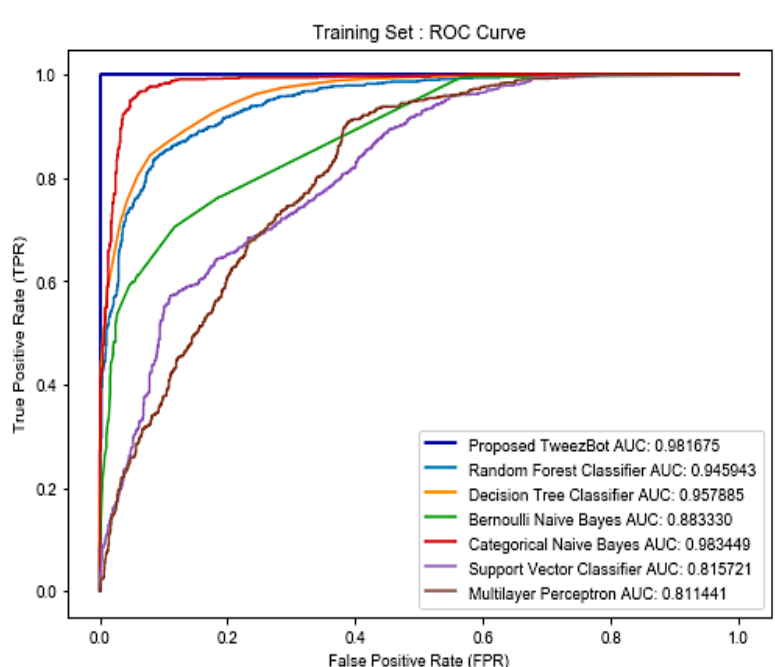
Figure 16. Comparative Analysis of Accuracy for Various Classifiers while Training .